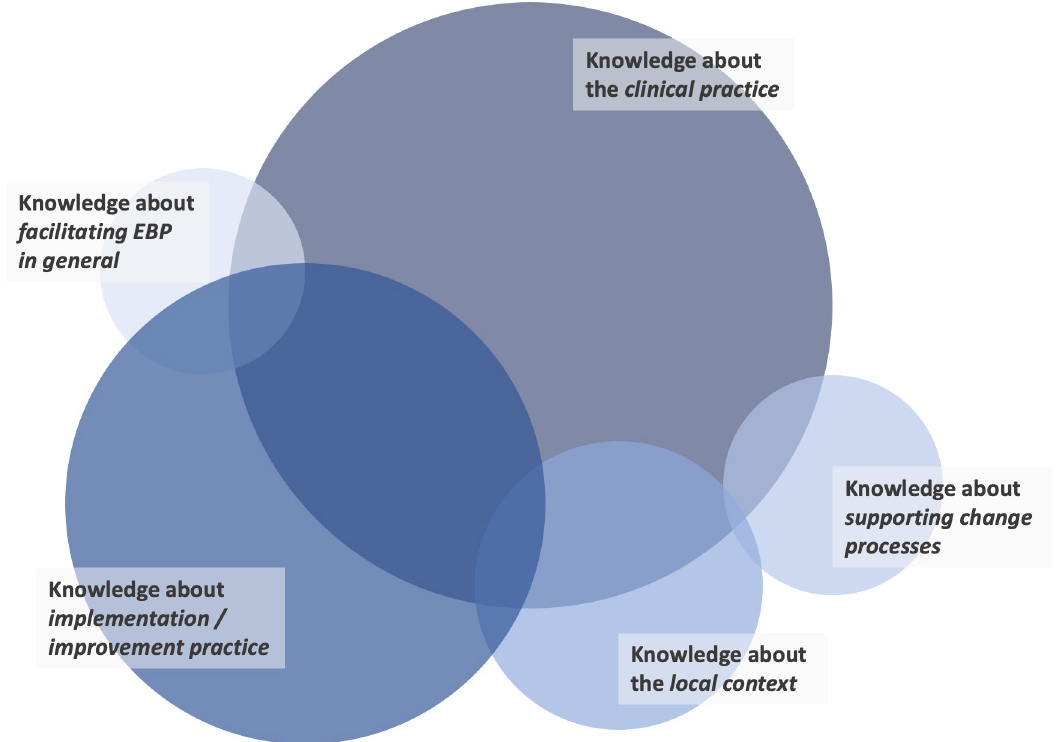
Fig 2. The five most present types of knowledge of ISPs in the included articles. The size of the circle indicates the number of studies which reported the specific knowledge area: knowledge about the clinical practice (n = 49), knowledge about implementation / improvement practice (n = 39), knowledge about the local context (n = 24), knowledge about supporting change processes (n = 20), knowledge about facilitating evidence-based practice (EBP) in general (n = 16). Publications were included in this visualization when they reported on at least one type of knowledge. The overlap between circles shows the co-presence of knowledge areas.